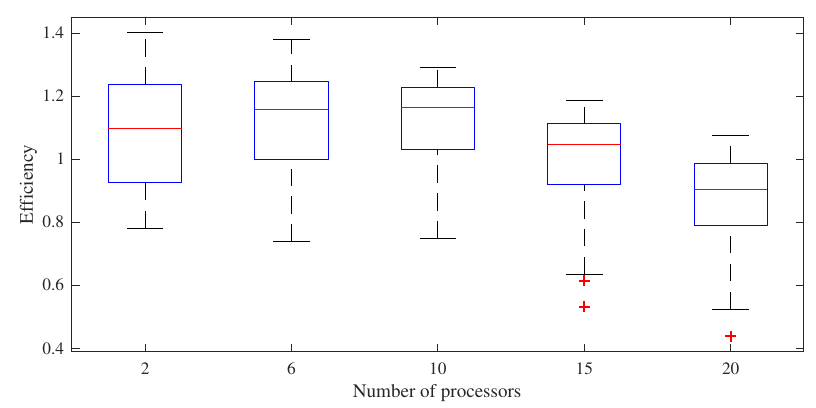
Figure 5. Box plot of the speedup results.